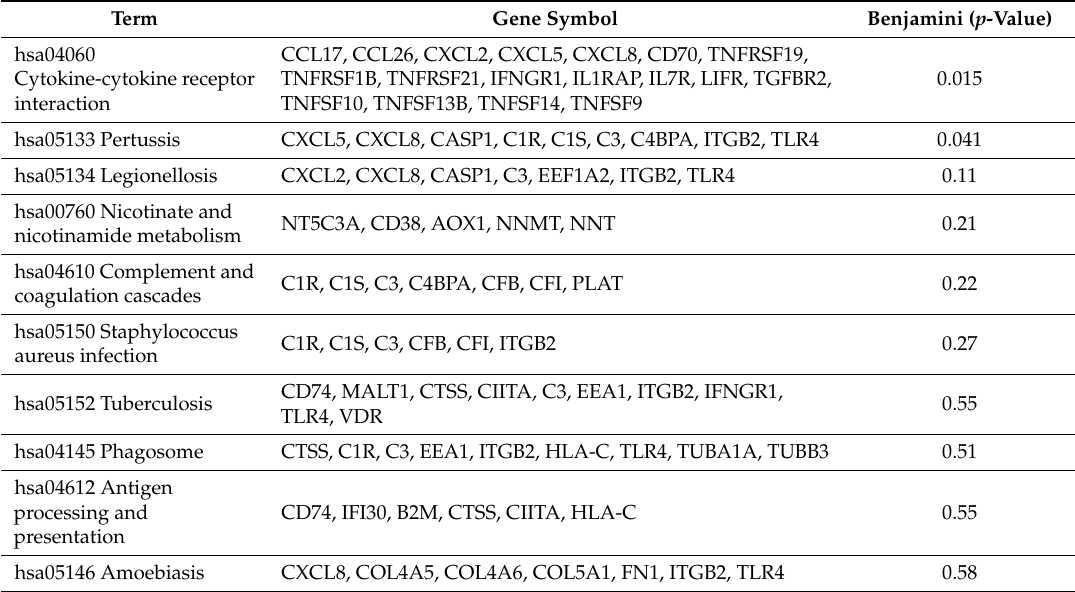
Table 2. Kyoto Encyclopedia of Genes and Genomes (KEGG) pathways over-represented in the genes that are up-regulated in both the infected KO-1 and KO-2